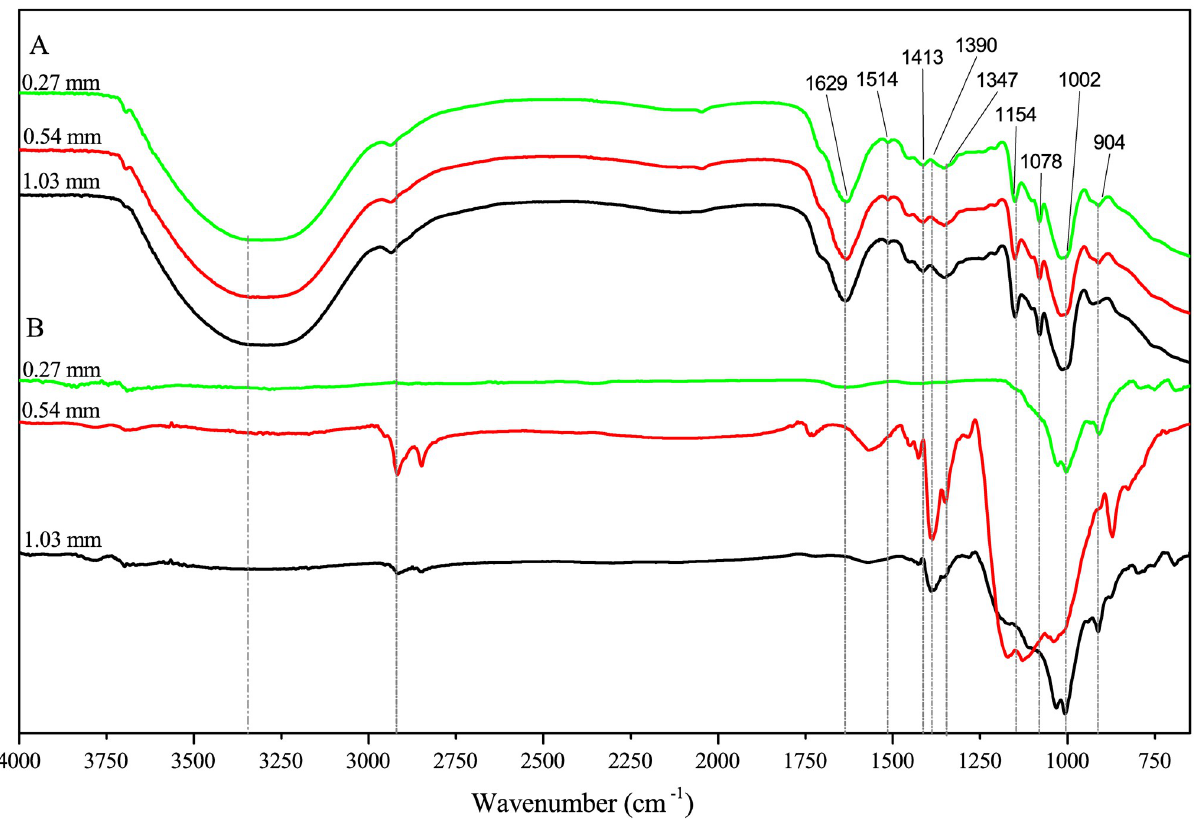
Fig 3. IR spectroscopy of non-biodegraded (A) and biodegraded (B) films after 30 days.